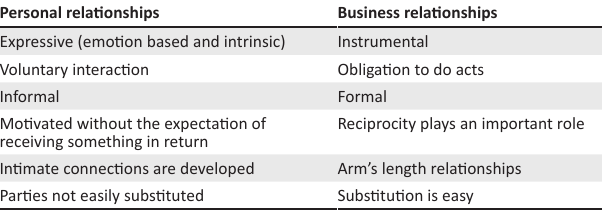
TABLE 1: Differences between personal and business